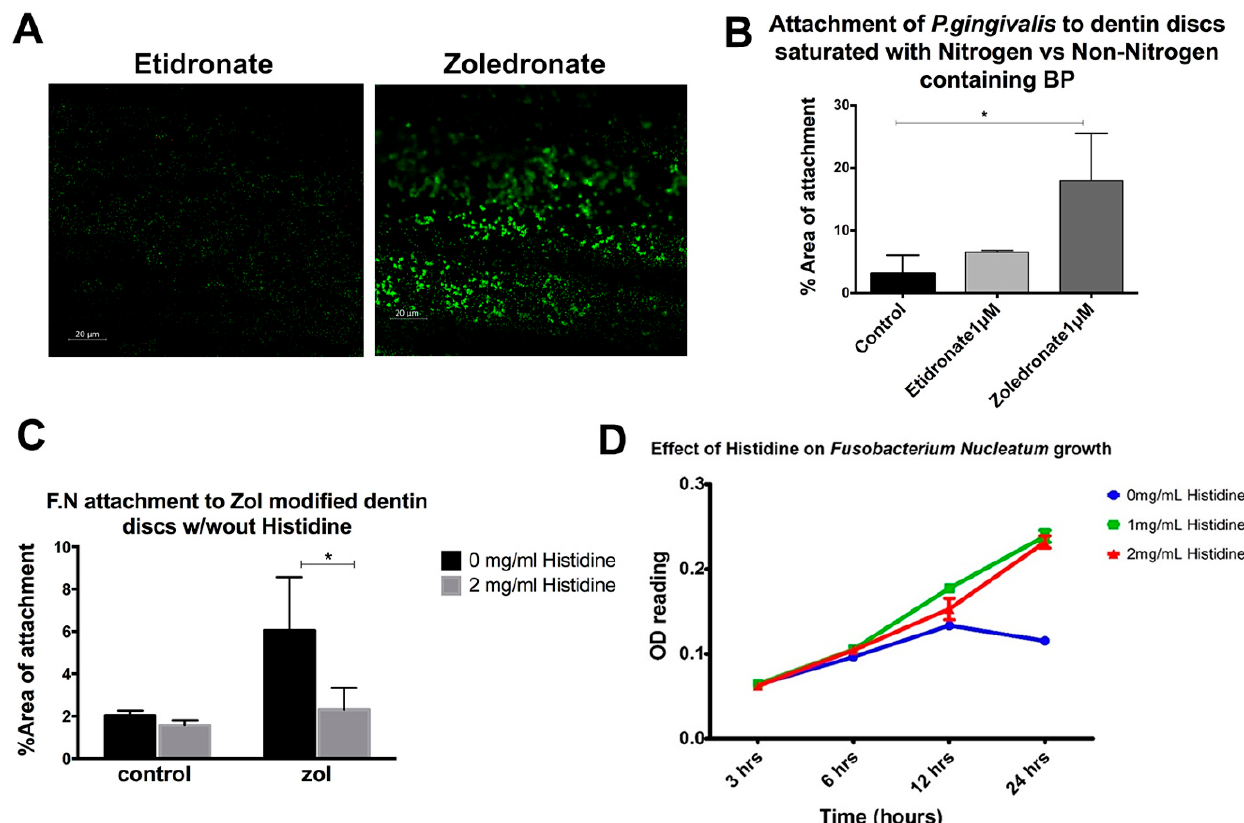
Figure 2. Role of the nitrogen group in bisphosphonate in enhancing the bacterial attachment to a mineralized matrix. ( A , B ) Quantitative analysis of the attachment of P. gingivalis pretreated with histidine on zol- and etidronate-coated dentin discs. ( C ) Attachment of F. nucleatum (FN) to zol-coated dentin discs with and without the histidine pre-treatment. ( D ) Growth curve of F. nucleatum with the histidine treatment (0 mg/mL, 1 mg/mL, 2 mg/mL) (* p < 0.05).